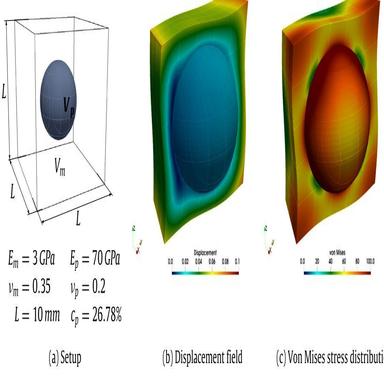
Hard spherical inclusion in a soft matrix.